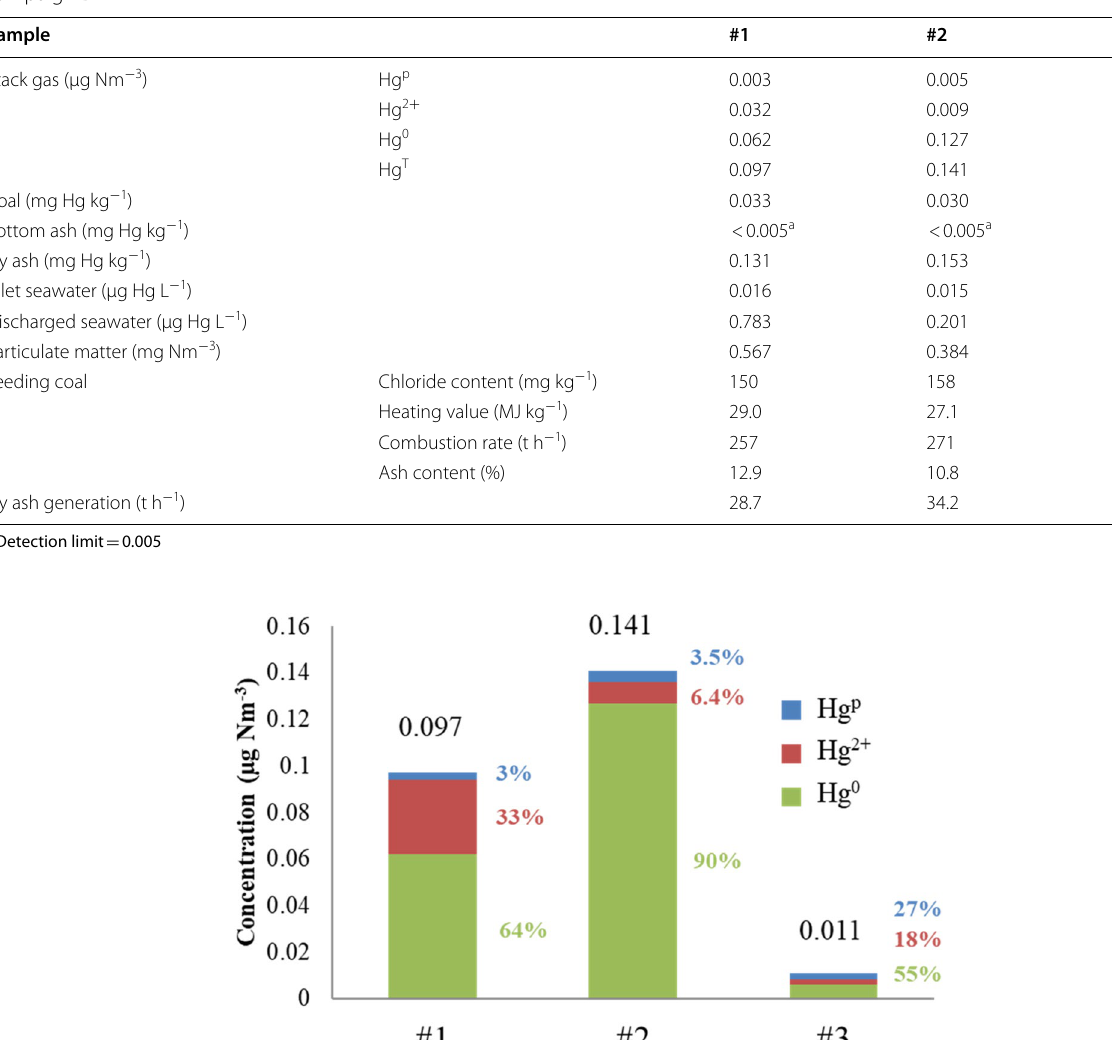
Table 5 Mercury content in solid and liquid samples and important parameters of the coal-fired power plant investigated during campaign D